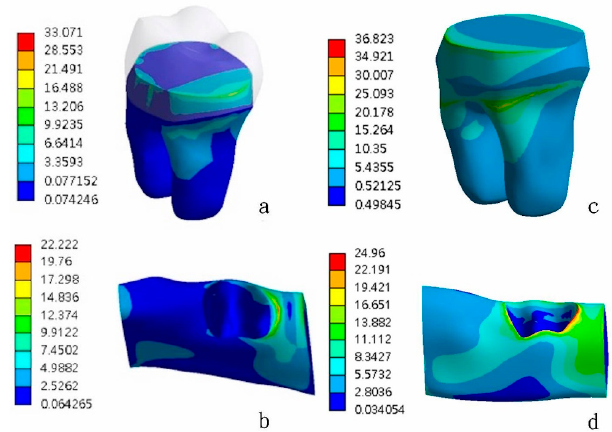
Figure 1. Distributions of the stresses on a primary molar covered with an all-ceramic crown. The maximum von Mises stress value (EQV) was concentrated in the proximal area of the primary root and cortical bone under vertical loading ( a , b ) and oblique loading ( c , d ).